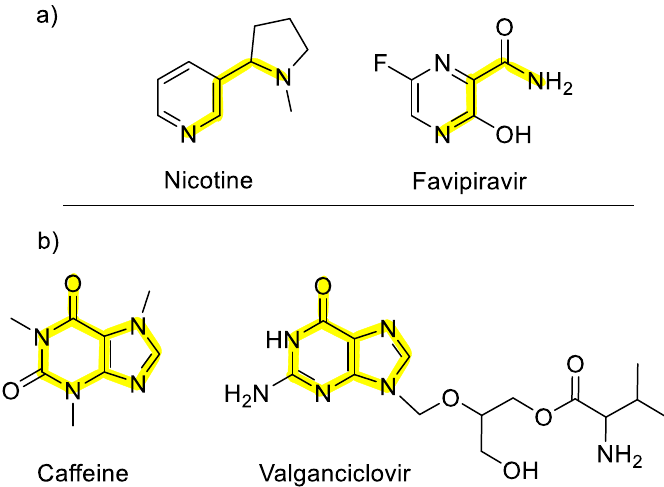
Figure 1. Comparing the chemical structure of ( a ) favipiravir with nicotine and ( b ) caffeine with valganciclovir; their similarities from chemical structure point of view are highlighted in yellow.